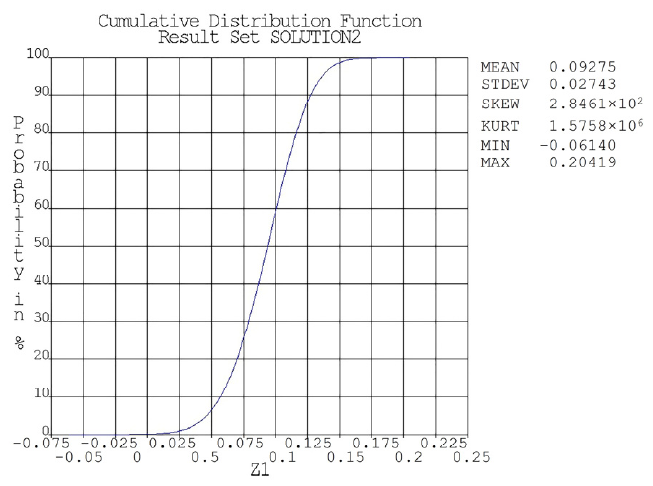
Figure 21. XDENS distribution histogram.